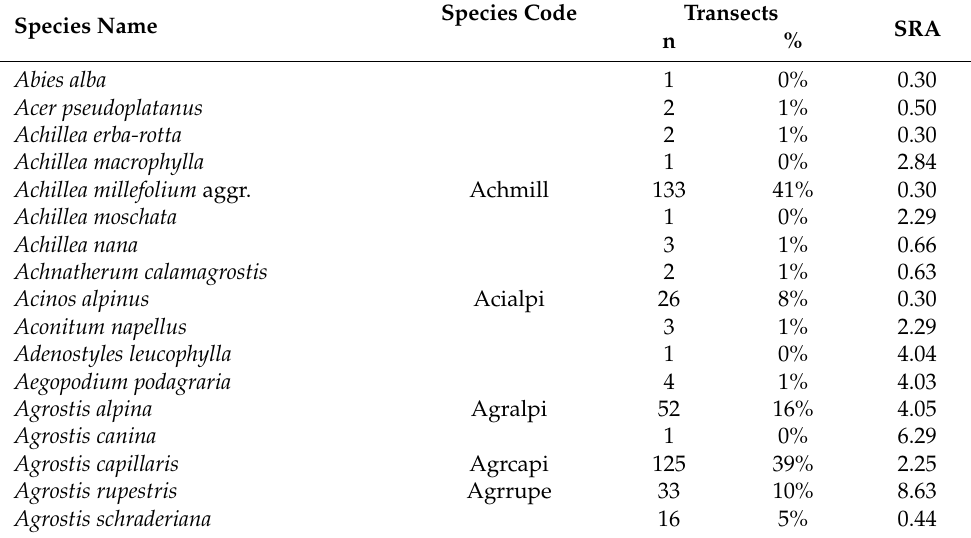
Table A2. List of plant species recorded in the 324 vegetation transects. The species code displayed in the biplots of the non-metric multidimensional scaling (NMDS), the number and proportion of tran- sects where the species was found, and the average species relative abundance (SRA) are